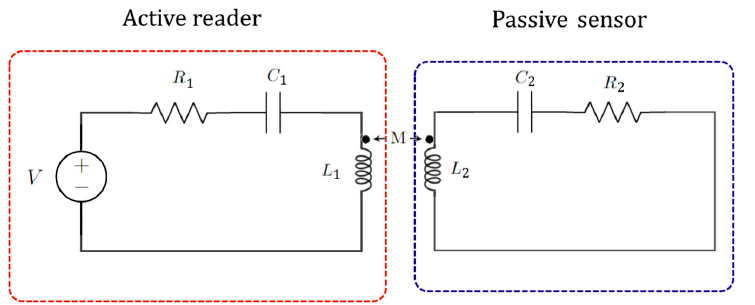
Figure 13. Generic implementation of coupled circuits for telemetry that can be particularized for non-Hermitian electronic sensing.